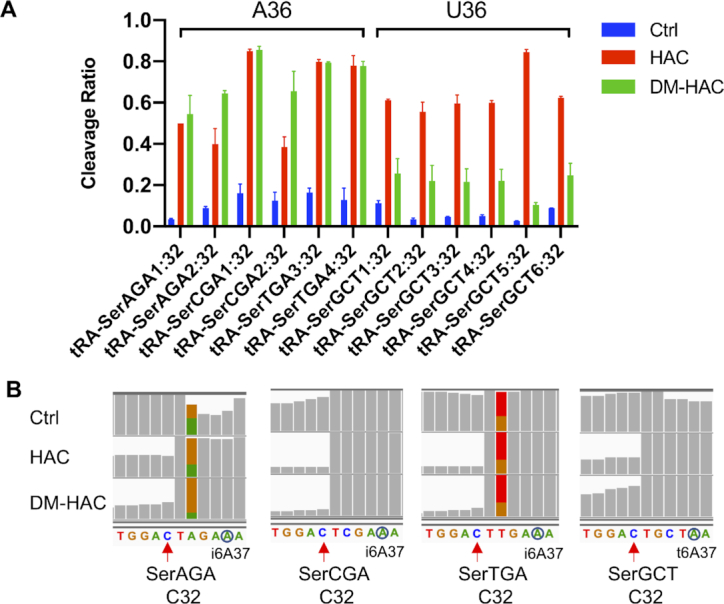
Differential detection of m3C32 modification of tRNA-Ser with A36 versus tRNA-Ser with U36 by HAC-seq. (A) Cleavage ratio plots of all m3C32 sites on different tRNA-Ser isoforms detected by HAC-seq. (B) IGV displays of read alignments around m3C32 sites on different tRNA-Ser isoforms. i6A36 and t6A36 are highlighted in blue circles.